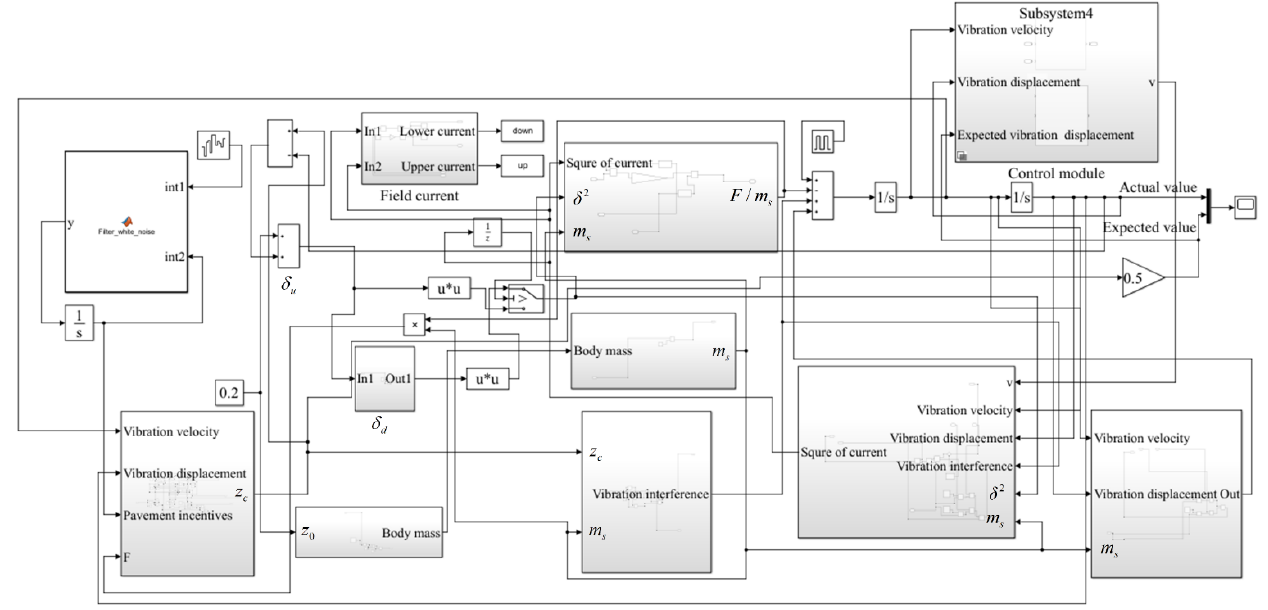
Figure 11. Simulink model of electromagnetic vibration damping system based on state feedback control and integral synovial control. Table 1. Simulation parameters of seat suspension.